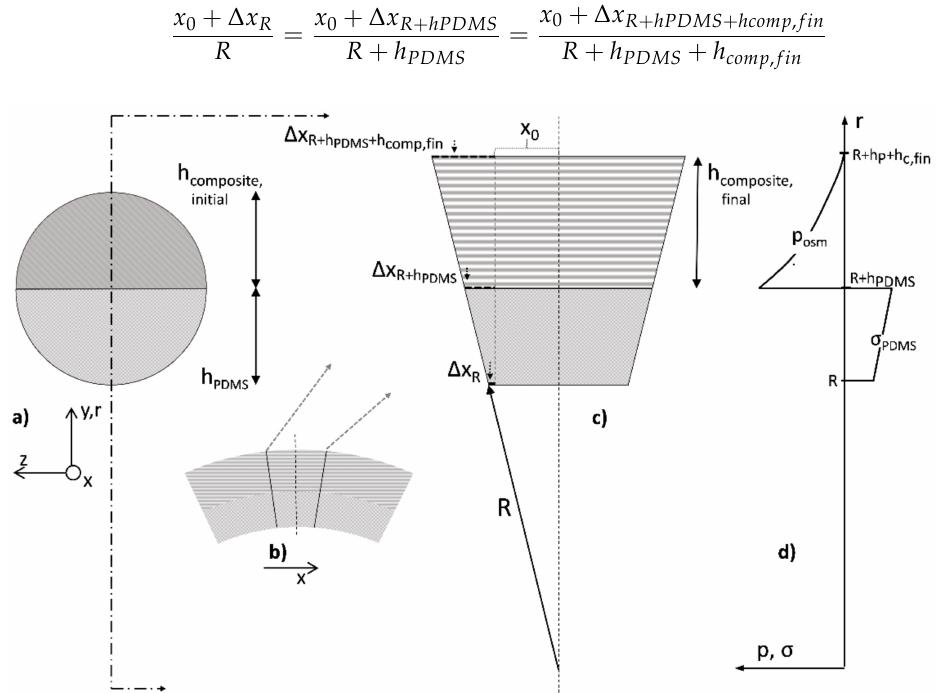
Figure 1. Swelling of cylindrical specimens “Design B”: ( a ) cross-section with pure silicone rubber (gray) and dry, initial silicone–hydrogel composite (hatched) compartments, ( b ) cross-section showing bending in (x-) direction due to swelling of the silicone–hydrogel composite, ( c ) calculation of elongations in x-direction for given bending radius R and final height of the composite layer and ( d ) schematic distribution of stress and pressure in PDMS and composite